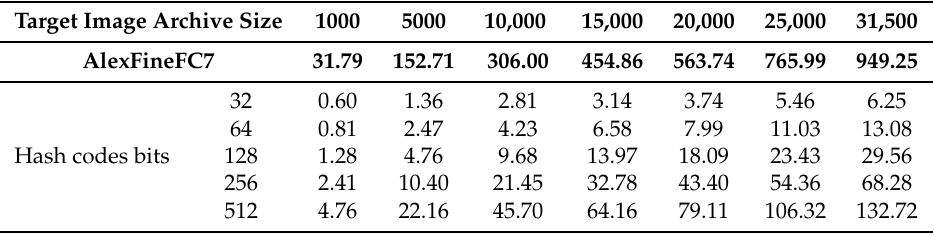
Table 10. Retrieval cost of similarity calculation and matching based on original features and hash codes with different length (unit: